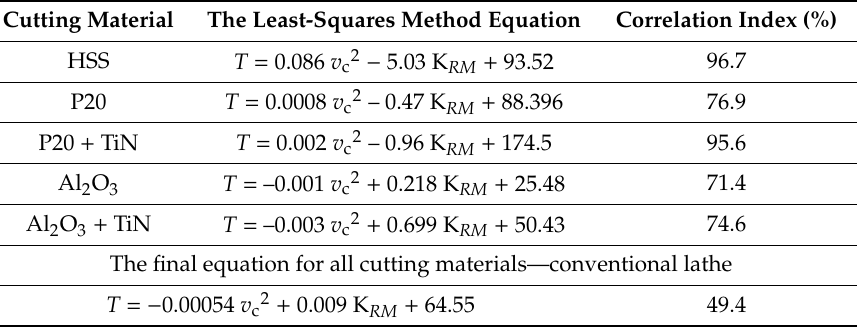
Table 8. T-v c equations for the conventional